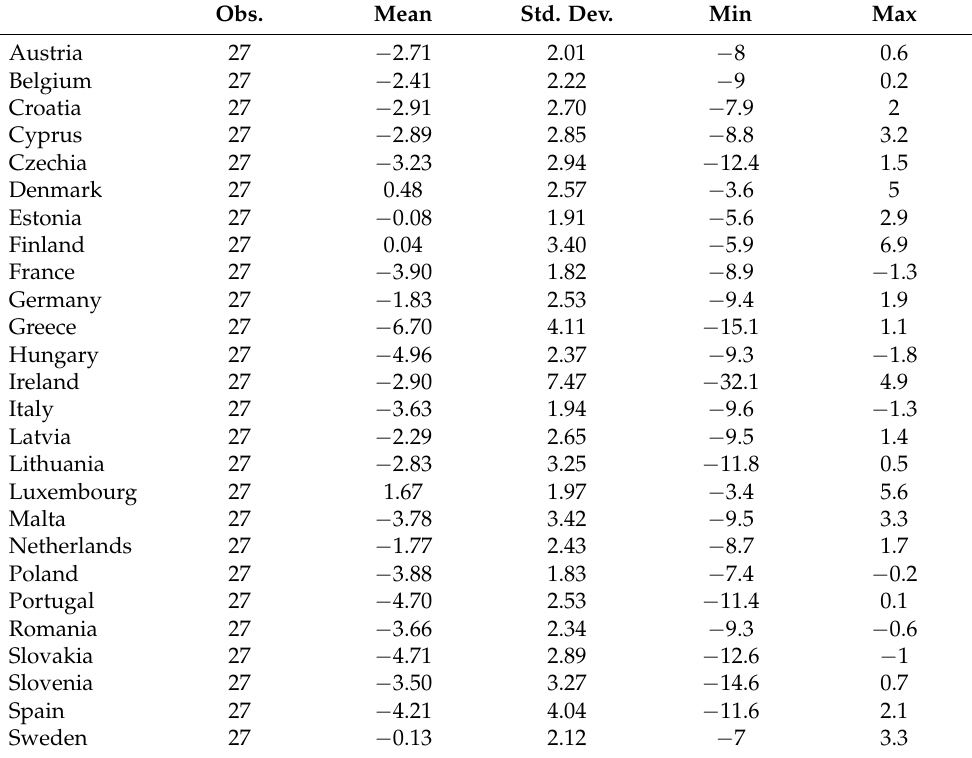
Table 2. Descriptive